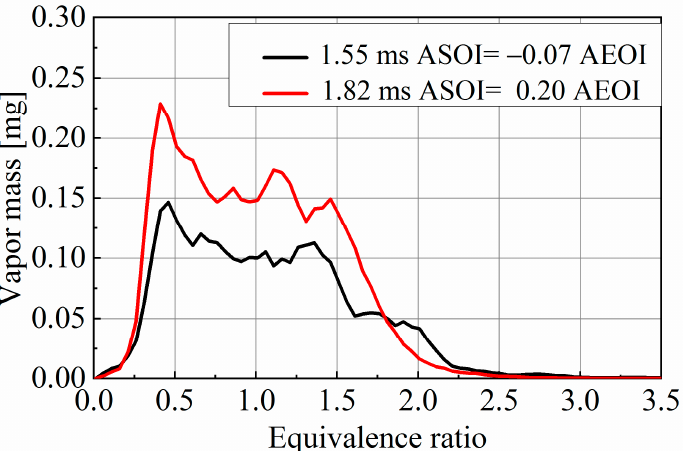
Figure 10. The comparison of the vapor mass distribution against equivalence ratio (T a = 800 K, P a = 4.8 MPa, P inj = 100 MPa, M f = 5.0 mg).